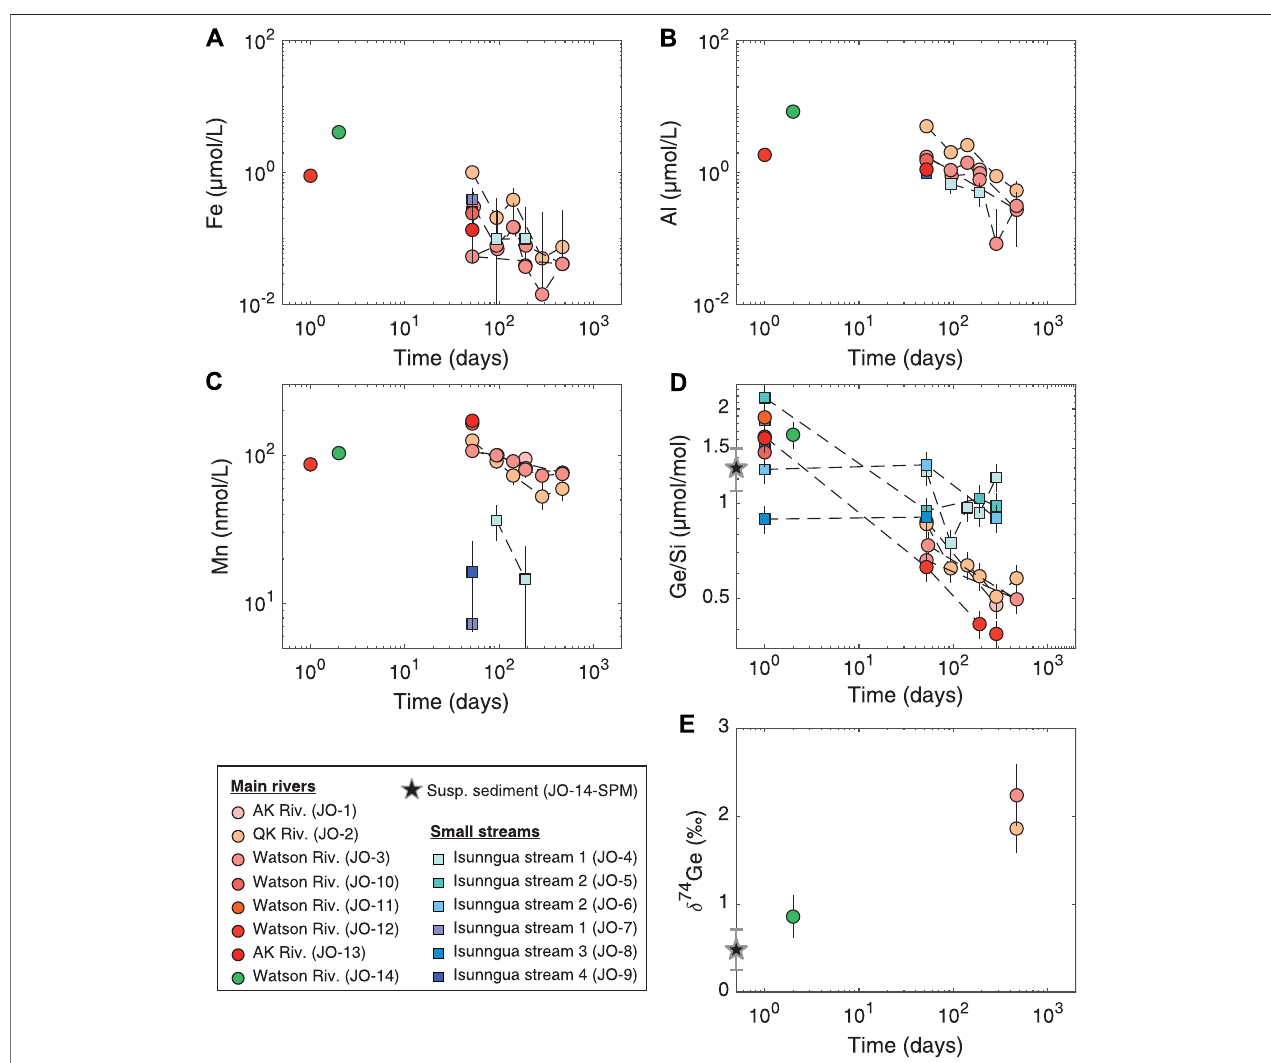
FIGURE 3 | Evolution of dissolved trace element concentrations, Ge/Si, and Ge isotope ratios during the course of lab weathering experiment. The Ge/Si and Ge isotope composition of the suspended sediment is shown as a black star at Time ≈ 0 in panels (D) and (E) .